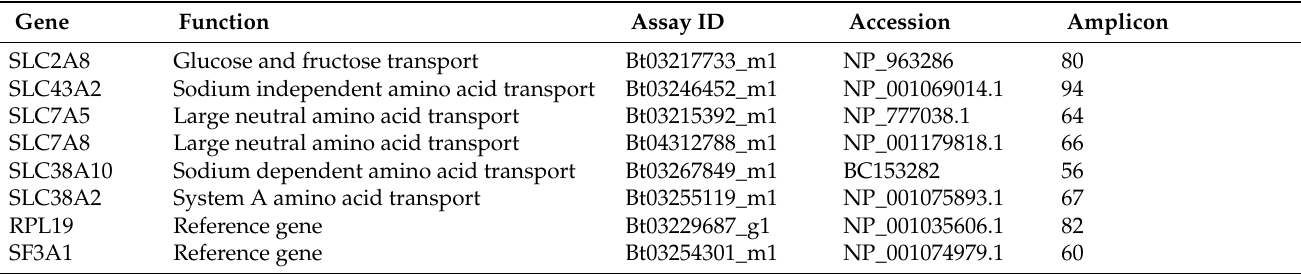
Table 1. Function, assays, accession, and amplicon length of primers used for TaqMan real-time PCR quantitation of placental gene expression. RPL19 and SF3A1 were used as housekeeping